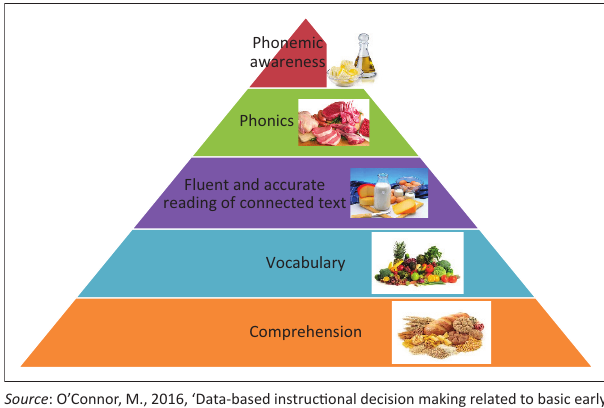
FIGURE 3: A reading literacy diet for Intermediate Phase learners reading at grade level.